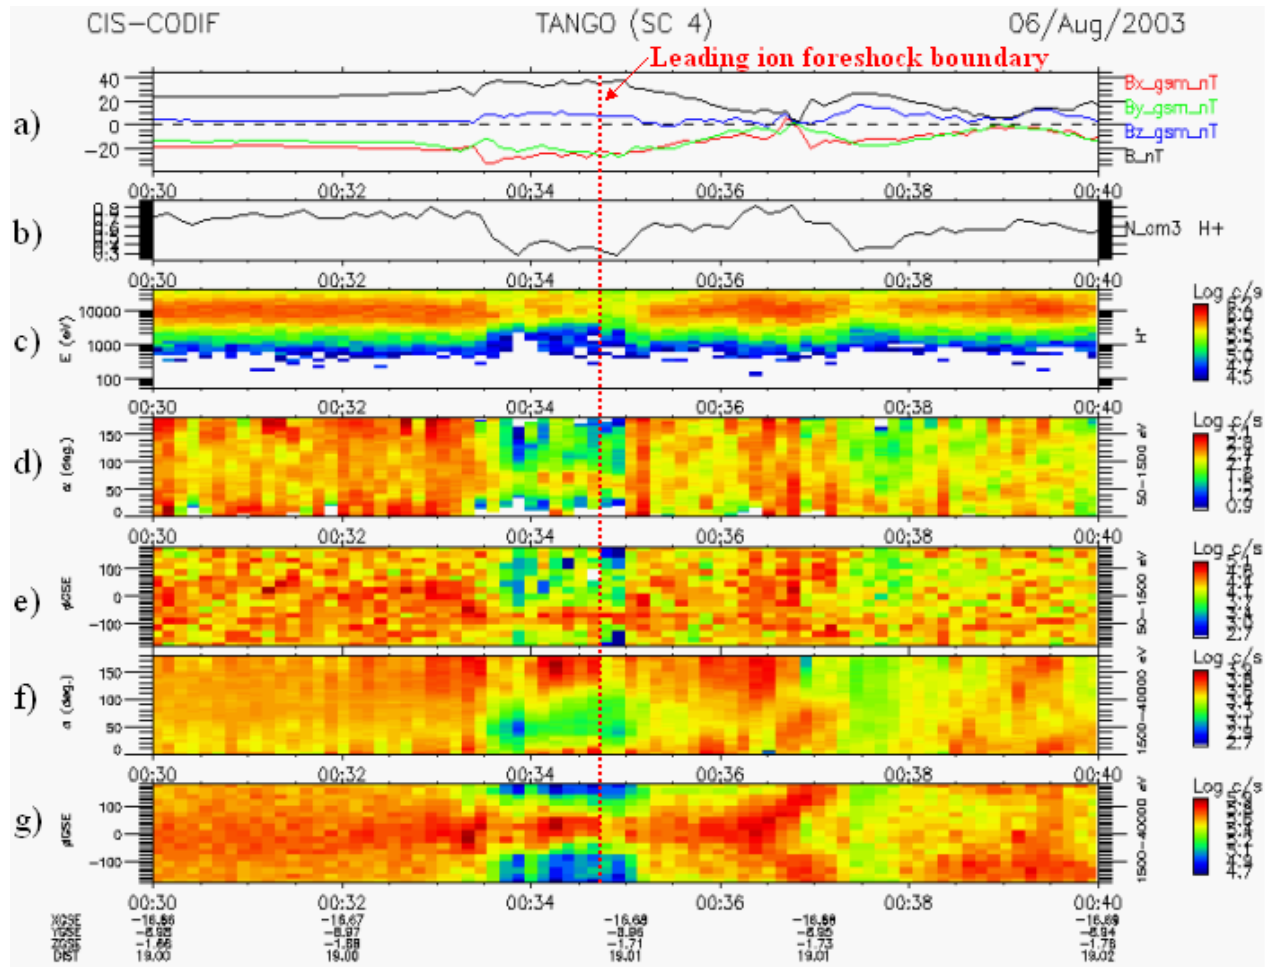
Fig. 3. A snapshot of the proton measurements in the cavity. The third panel is the time-energy spectrogram. The fourth and fifth panels show the spectrogram of the pitch angle and azimuthal angle respectively for protons within the energy range 50–1500eV, and the sixth and seventh panels show those for protons within the higher energy range